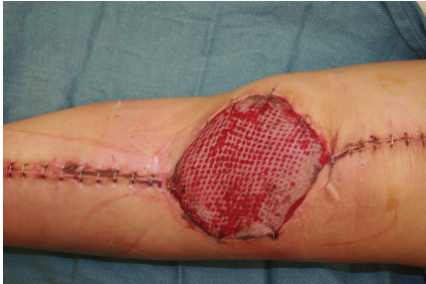
Figure 4: Gastrocnemius flap and split thickness skin graft at 1